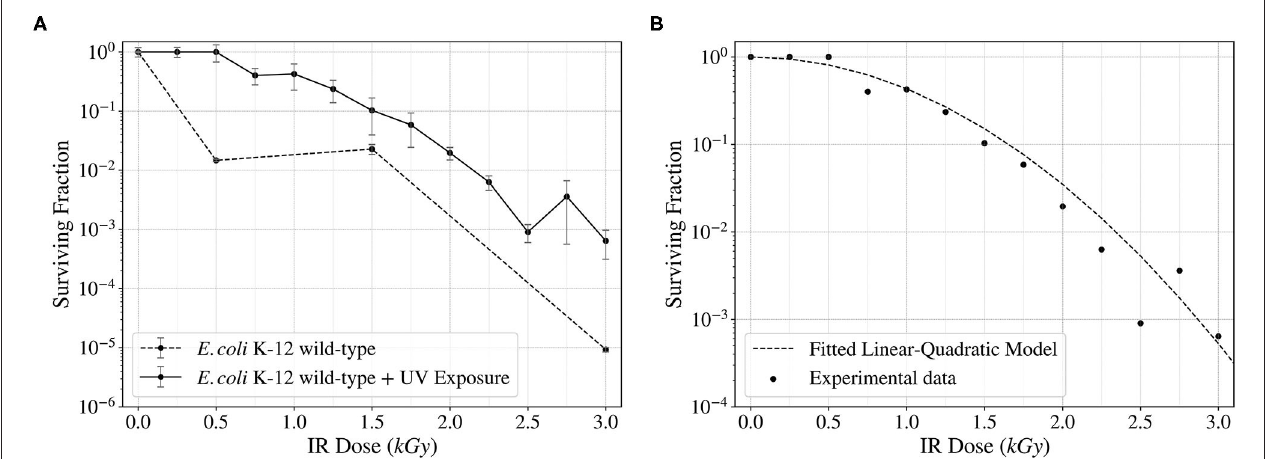
FIGURE 4 | Surviving fraction of wild-type E. coli K-12 cells after being exposed to a continuous spectrum of X-rays (Ionizing Radiation) up to 3,000 Gy (12.6 Gy/min). Comparison of the surviving fraction with and without a previous UV Fluence exposure (A) and fitted linear-quadratic model showing the trend of the surviving frequency (B) .